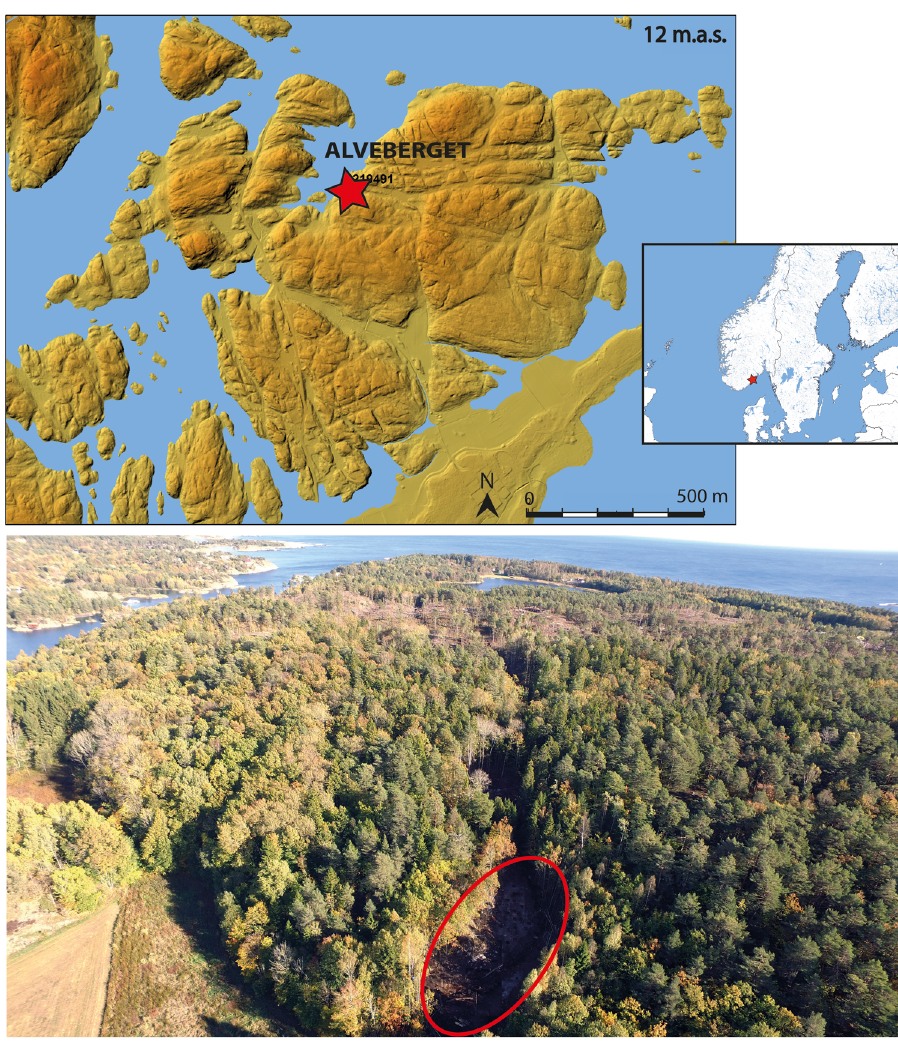
Figure 1: Alveberget is located on the eastern Skagerrak coast in Arendal, Agder County ( upper, right ) . In the Middle Neolithic, when the sea - level was about 12 meters higher than at present, the area was an archiplago with eminent potential for in - shore and out - shore fi shing. The site was situated on a small island, sloping down towards a sheltered bay ( Illustration: J. S. F. Stokke/S. Kristensen/I. M. Berg - Hansen © 2020 Museum of Cultural History, University of Oslo )